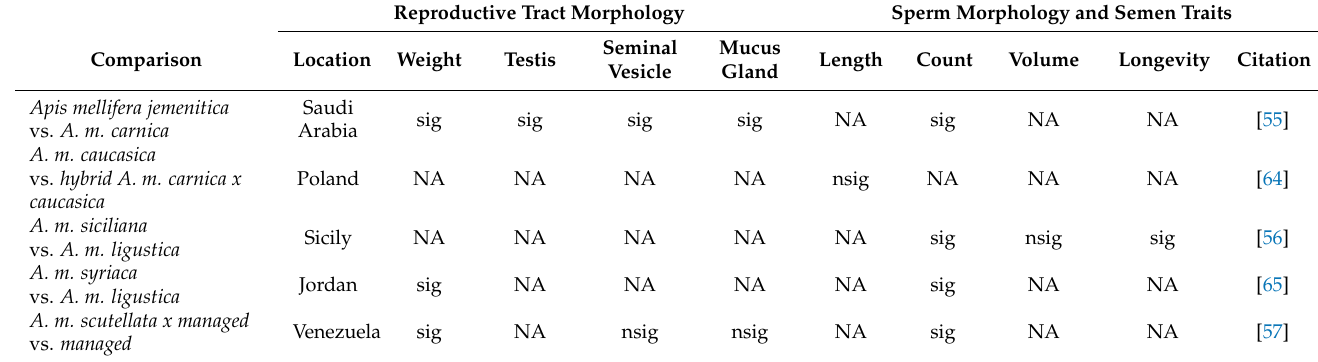
Table 1. Common garden experiments among honey bee subspecies that have specifically examined sperm- or fertility- associated traits in honey bee males. Drone characteristics among honey bee subspecies indicate that there is a genetic component to drone reproductive traits. NA = Not Available; sig = Significant Differences; nsig = No Significant Differences. Reproductive Tract Morphology Sperm Morphology and Semen Traits Seminal Volume Longevity Citation Comparison Location Weight Testis Vesicle Apis mellifera jemenitica vs. A. m.